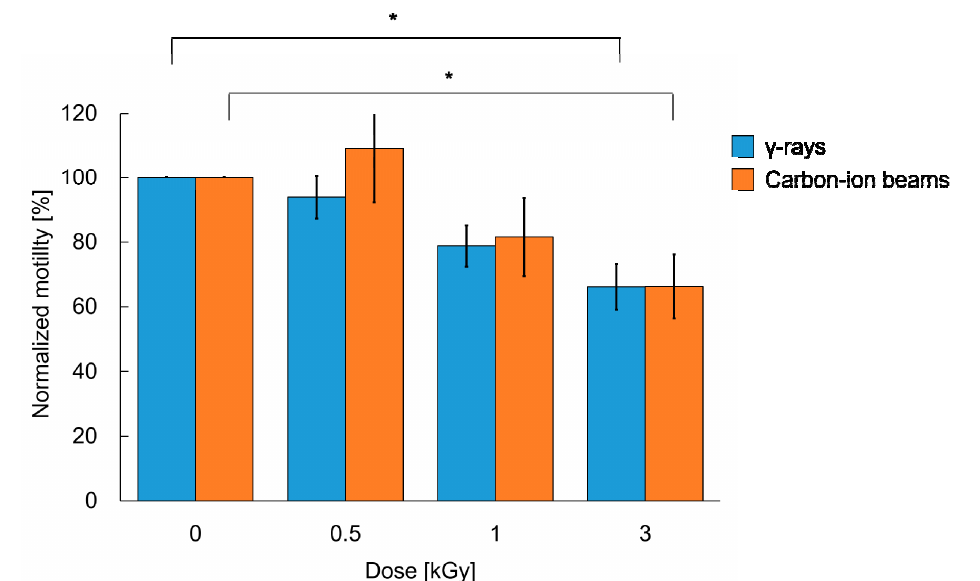
Figure 4. Crawling ability of C. elegans 24 h after whole-body irradiation with different doses of γ -rays and carbon ion beams. Normalized value of motility of worms 24 h (one day) after irradiation. Track length (trajectory) of the center point of the body in crawling on agar for 5-s was derived from a video based on the same procedure shown in Figure 3. Thirty worms were tested in each condition in 6 trials of γ -rays irradiation (5 worms per condition per trial). Twenty worms were tested in each condition in 4 trials of carbon-ion-beams irradiation (5 worms per condition per trial). The mean values of the normalized motility of 6 or 4 irradiation trials are presented in blue or orange, respectively. Error bar indicates SEM. The data were analyzed by the Student’s t -test. * indicates p- value < 0.05, significantly different from 0 Gy.